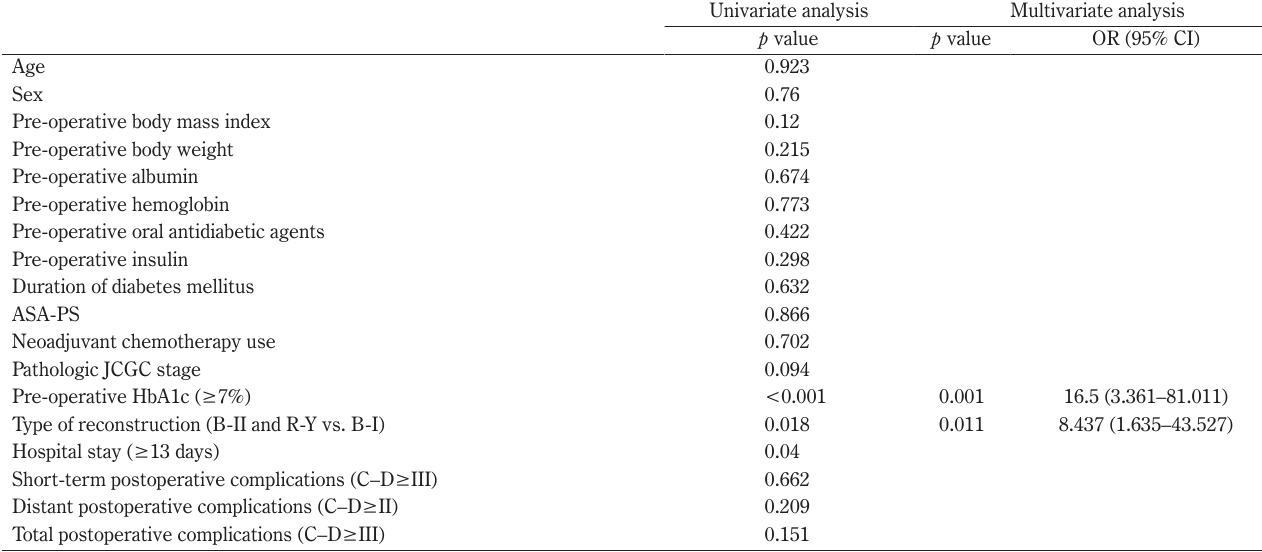
Table 7 Factors associated with postoperative improvement of HbA1c levels (TP0– TP3)